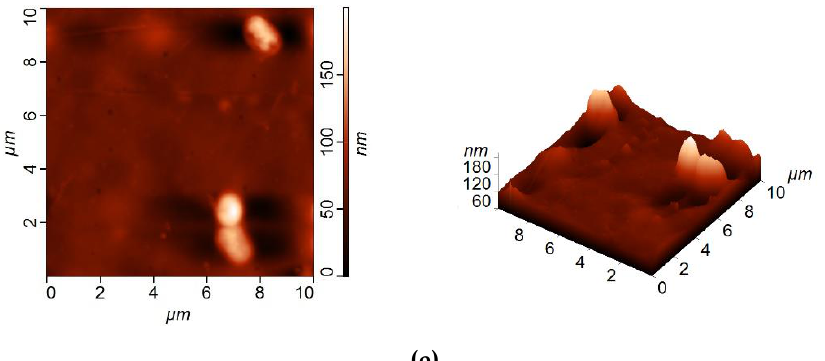
Figure 5. AFM images of the selective layer surface of the TFC and TFN membranes: ( a ) D0; ( b ) D0-IP; ( c ) D0-IP1; ( d ) D0-IP3; ( e ) D0-IP5. Table 3. Roughness parameters of the selective layer surface of the TFC and TFN